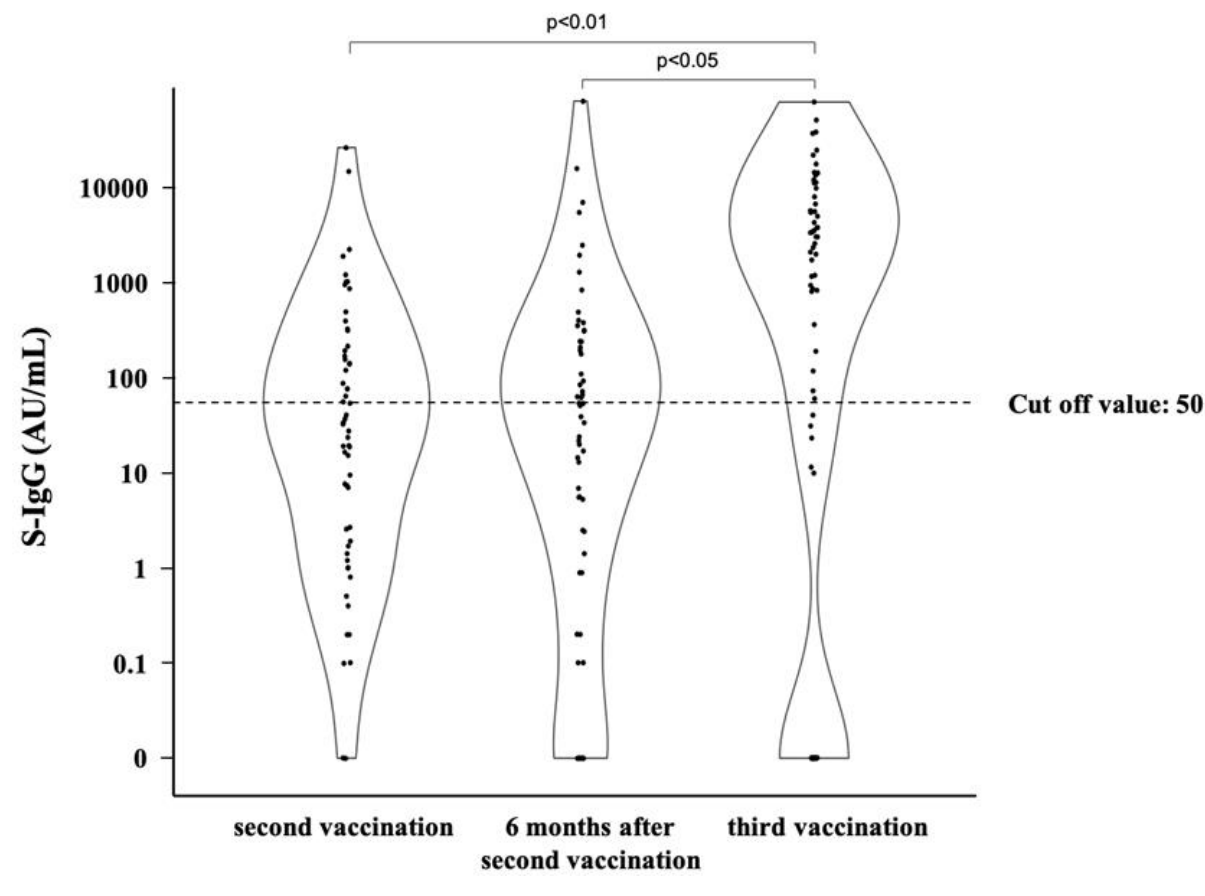
Figure 1. Changes in S-IgG titers in the post-kidney-transplant patients. The dots indicate the values of SARS-CoV-2 spike-IgG antibodies. The dotted line indicates the cutoff